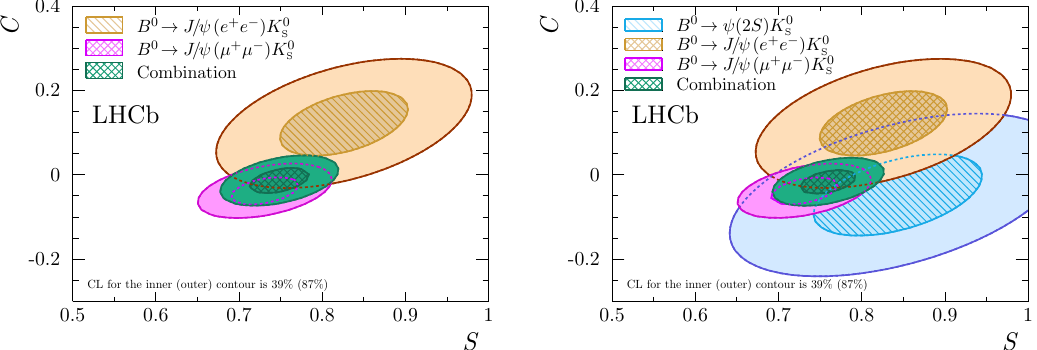
Figure 4 . Two-dimensional likelihood scans for the combination of the (left) B 0 ! J= K 0 and (right) all B 0 ! [ cc ] K 0 modes. The con(cid:12)dence level for the inner (outer) contour is 39% (87%). S with a correlation coe(cid:14)cient of 0 : 42. These results are consistent with indirect measure- ments by the CKM(cid:12)tter group [9] and the UT(cid:12)t collaboration [10]. Furthermore, they improve the precision of sin 2 (cid:12) at LHCb by 20 %, and are expected to improve the